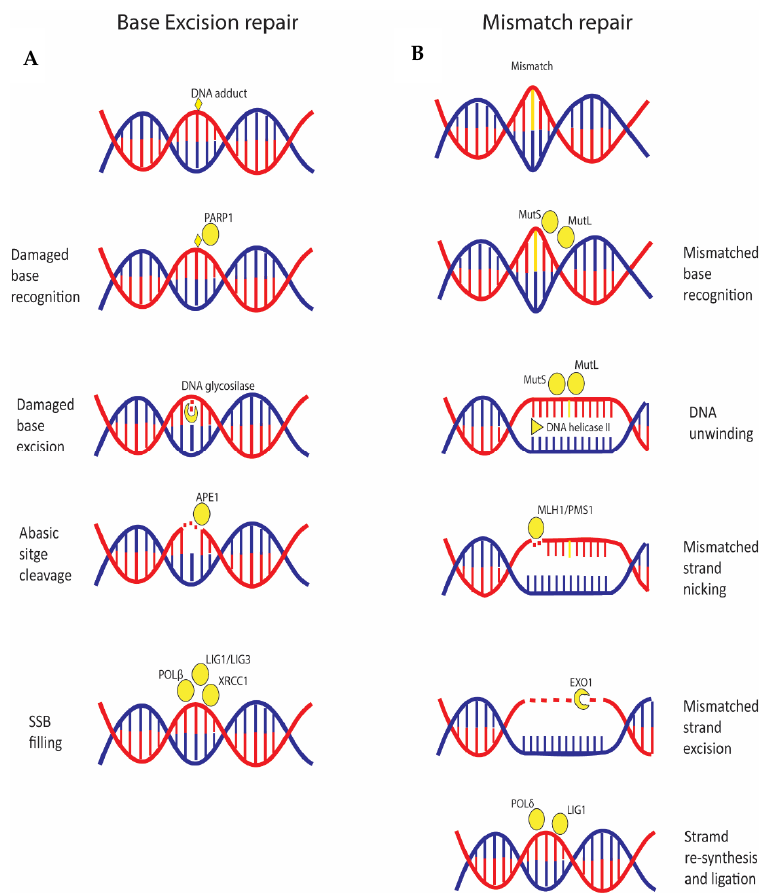
Figure 3. Small base lesions are repaired by base excision repair; mismatched base pairs and insertion/deletion loops are corrected by mismatch repair pathway. ( A ) DNA lesion is recognized by PARP1 which recruits a DNA glycosylase that removes the damaged base; then, APE1 digests the abasic site determining a SSB that is repaired by the combined action of LIG1/3, XRCC1 and Pol-β. ( B ) The mismatched base is recognized by the complexes MutS and MutL that, in turn, recruit the DNA helicases II to unwind the DNA strands; thereafter, the complex formed by MLH1/PMS1 digests DNA several bases from the mismatch, forming a nick. The EXO1 nuclease digests the DNA